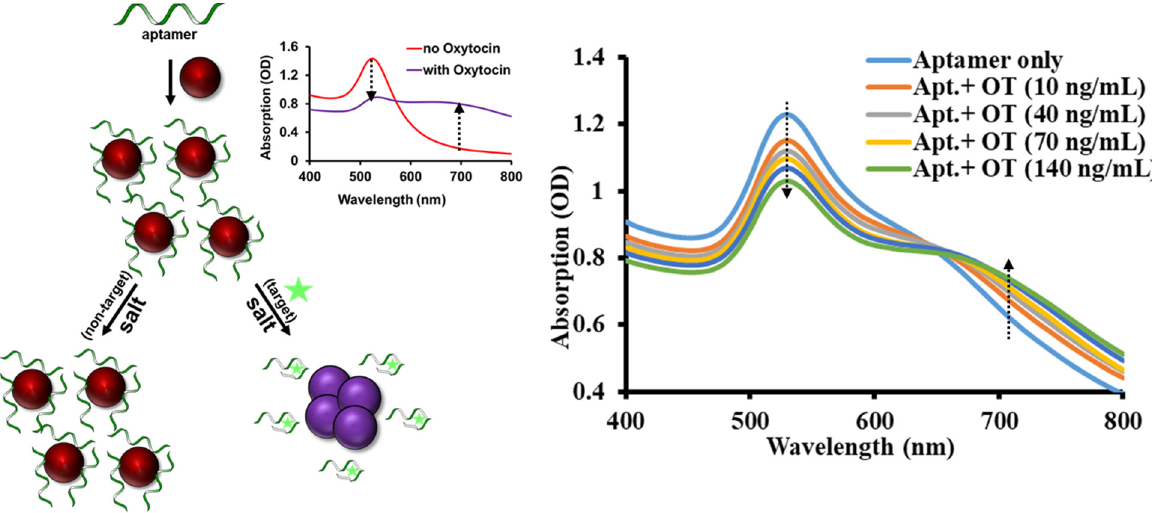
Figure 2 . Gold nanoparticle assay scheme. Raptamer with a random coil structure binds to gold nanoparticles (AuNP). Binding induces a conformation change to a rigid stem-loop structure and the AuNPs aggregate, leading to absorption changes at 520 nm and 700 nm. The green star represents oxytocin targets.